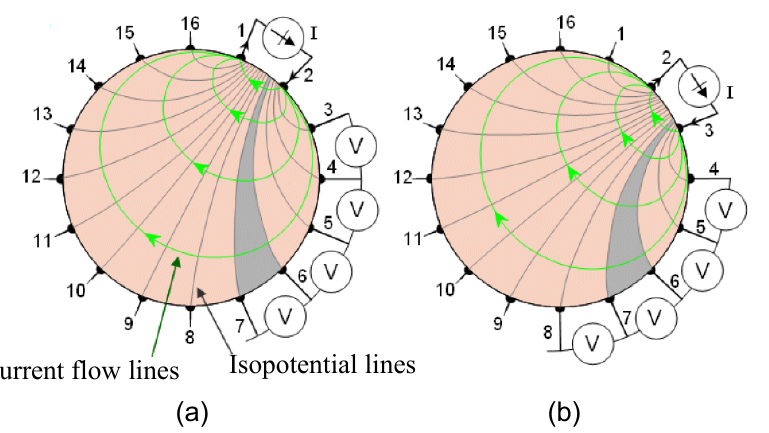
Figure 3. Adjacent measurement method, taken from [74]. ( a ) First measurement process: the current is injected between electrodes 1 and 2; ( b ) Second measurement process: the current is injected between electrodes 2 and